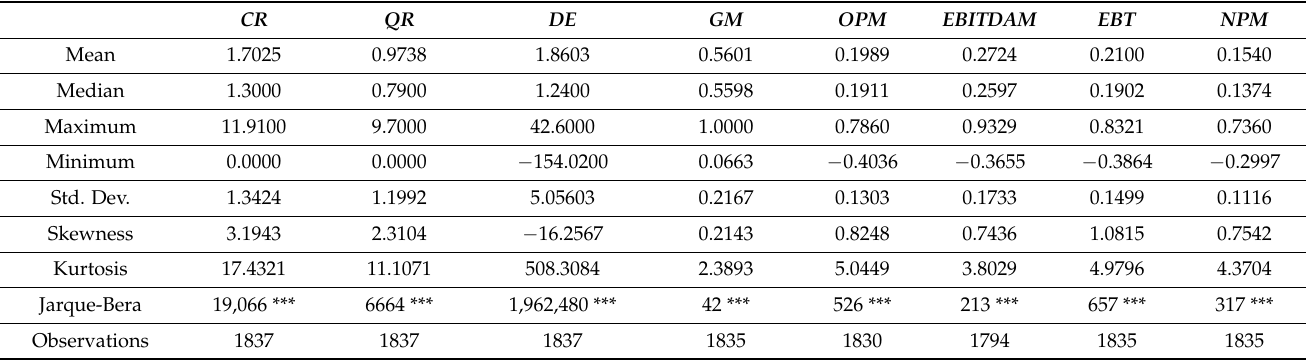
Table 1. Descriptive statistics for the variables of interest.